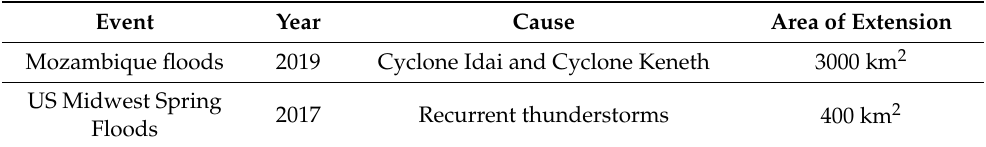
Table 3. Case studies.